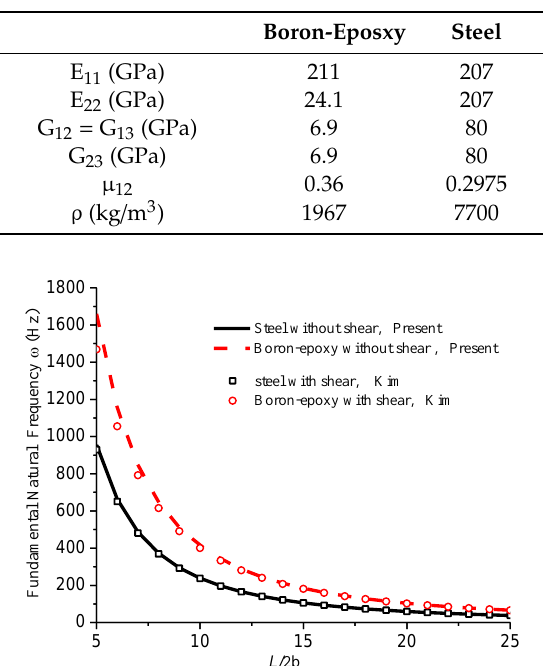
Figure 4. The influence of aspect ratio on fundamental frequency ( Ω = 0).